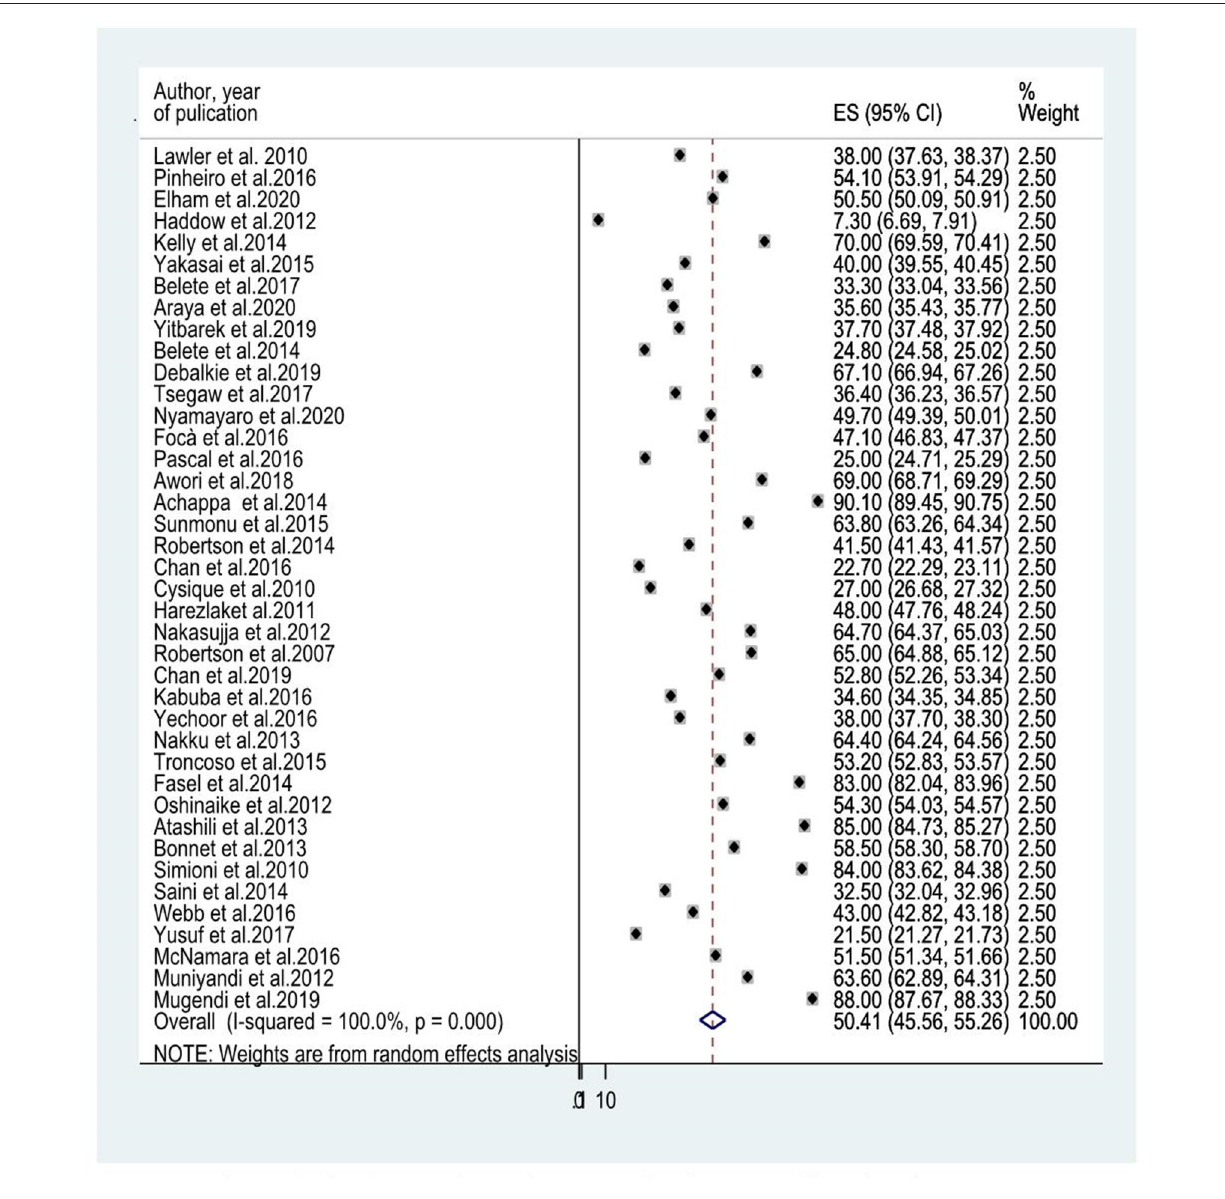
FIGURE 2 | A forest plot for the prevalence od HIV associated neurocognitive